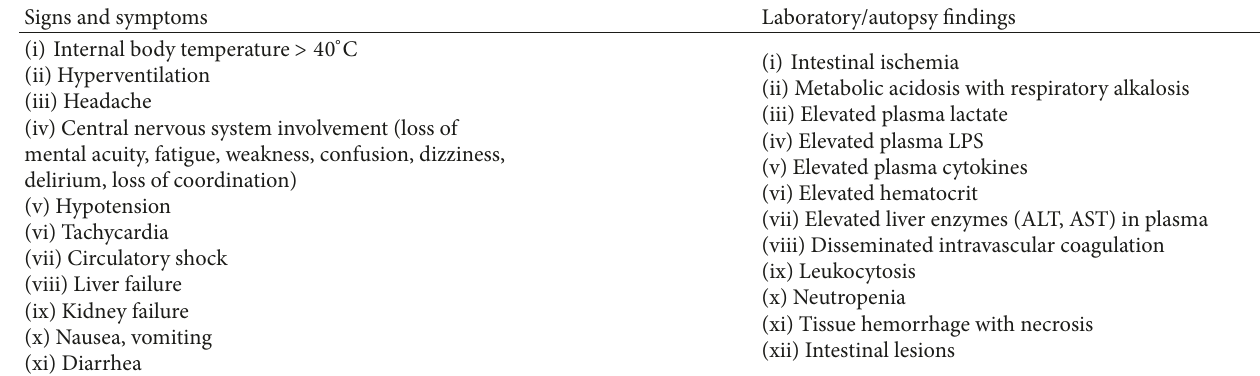
Table 6: Clinical and laboratory results, which are observed in advanced cases of exertional heatstroke and exemplify multiple organ dysfunction or